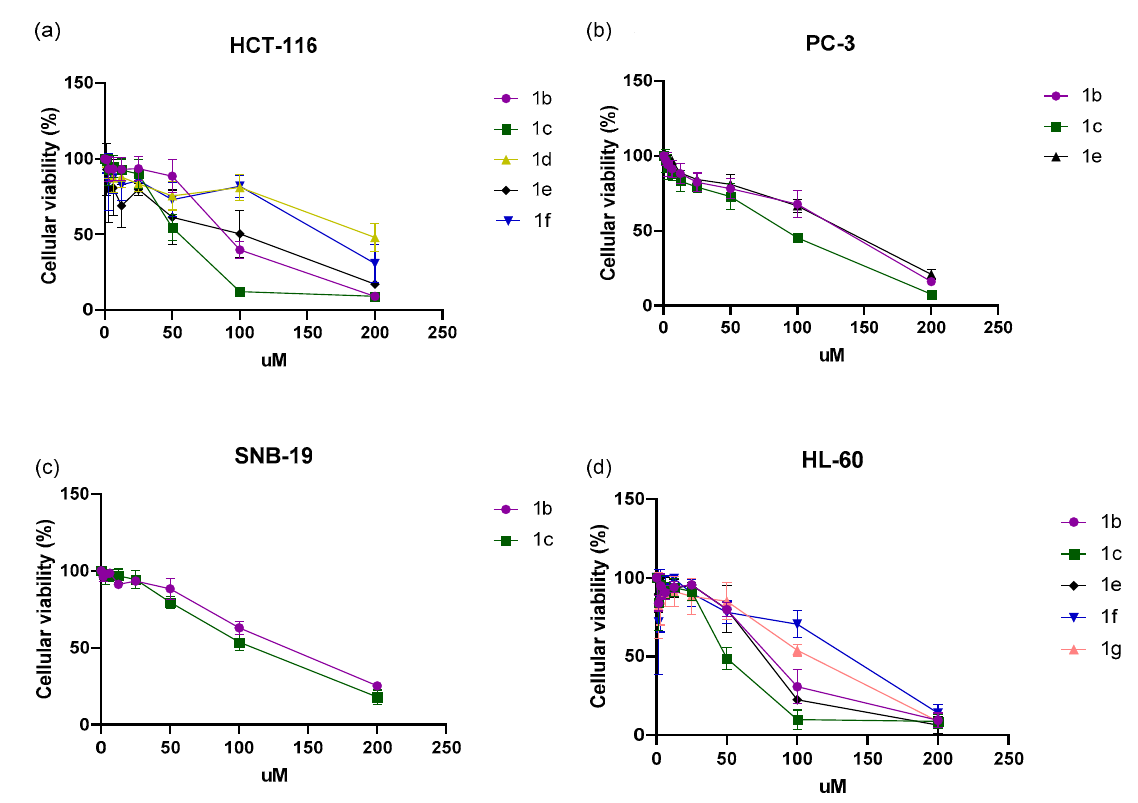
Figure 3. Inhibitory concentration means (IC 50 ) of the synthesized compounds 1b – c and 1e – g against the (a) HCT116; (b) PC3; (c) HL60; and (d) SNB19 tumoral cell lines.